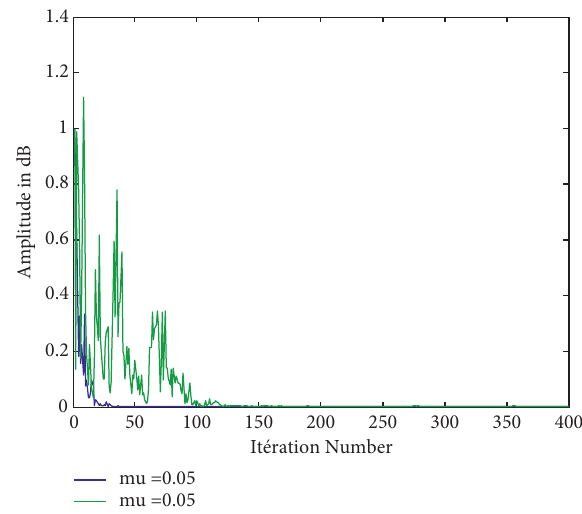
Figure 5: Magnitude of error vs iteration number